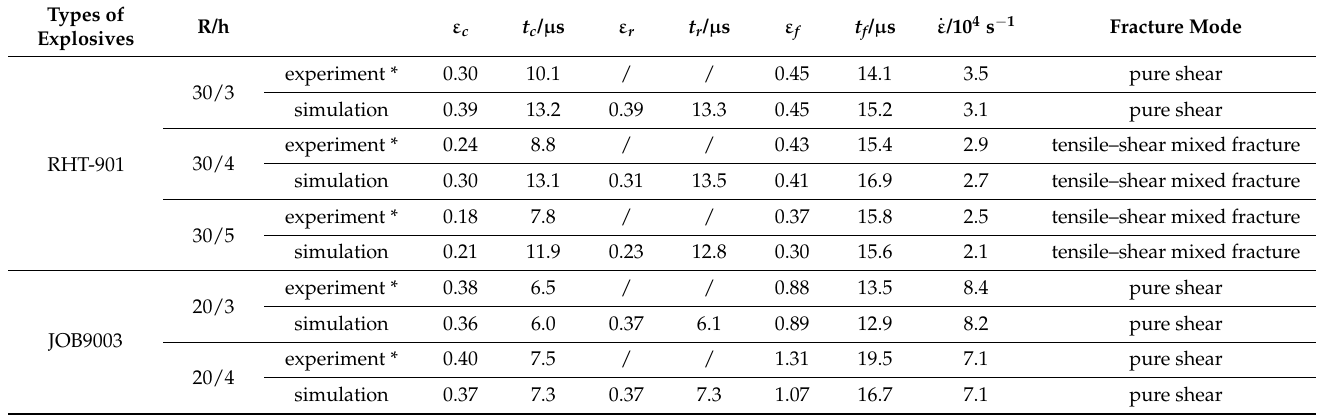
Table 4. Comparison of numerical simulation and experiment results.